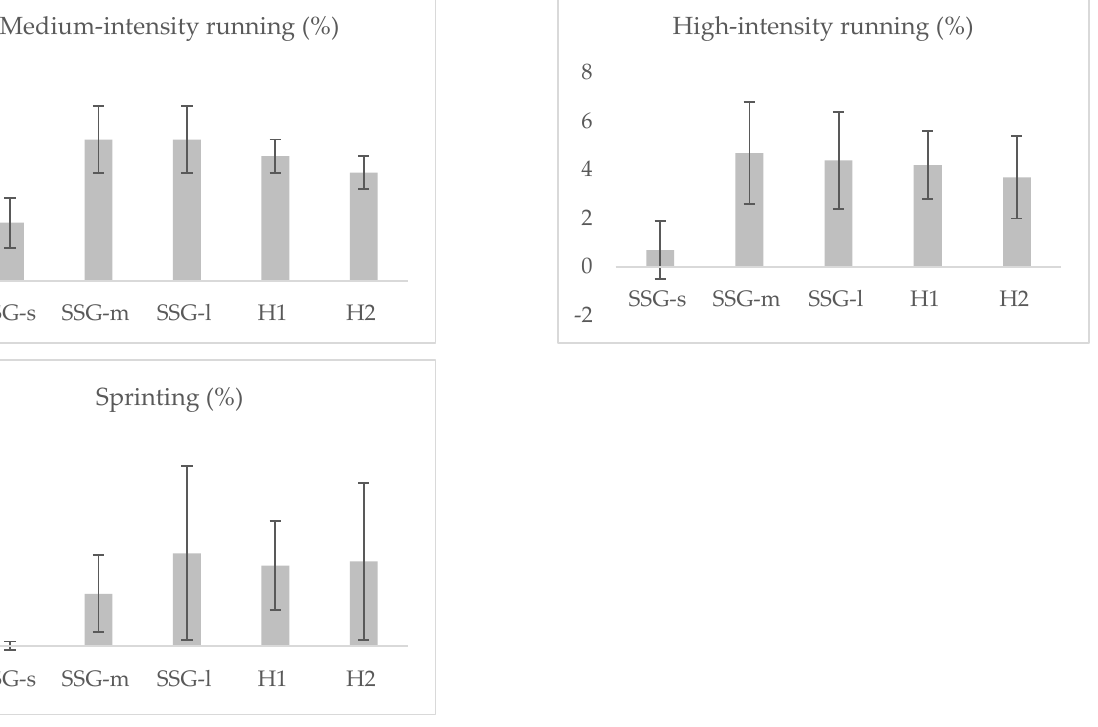
distance covered between 0.1 – 6.9 km·h −1 ; Low-intensity running: distance covered between 7.0 –